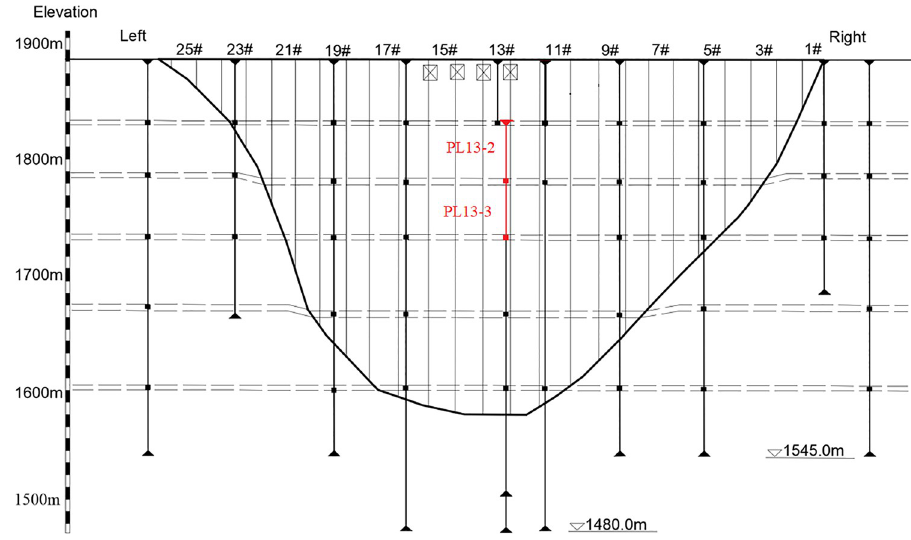
Fig 27. Vertical arrangement of the dam